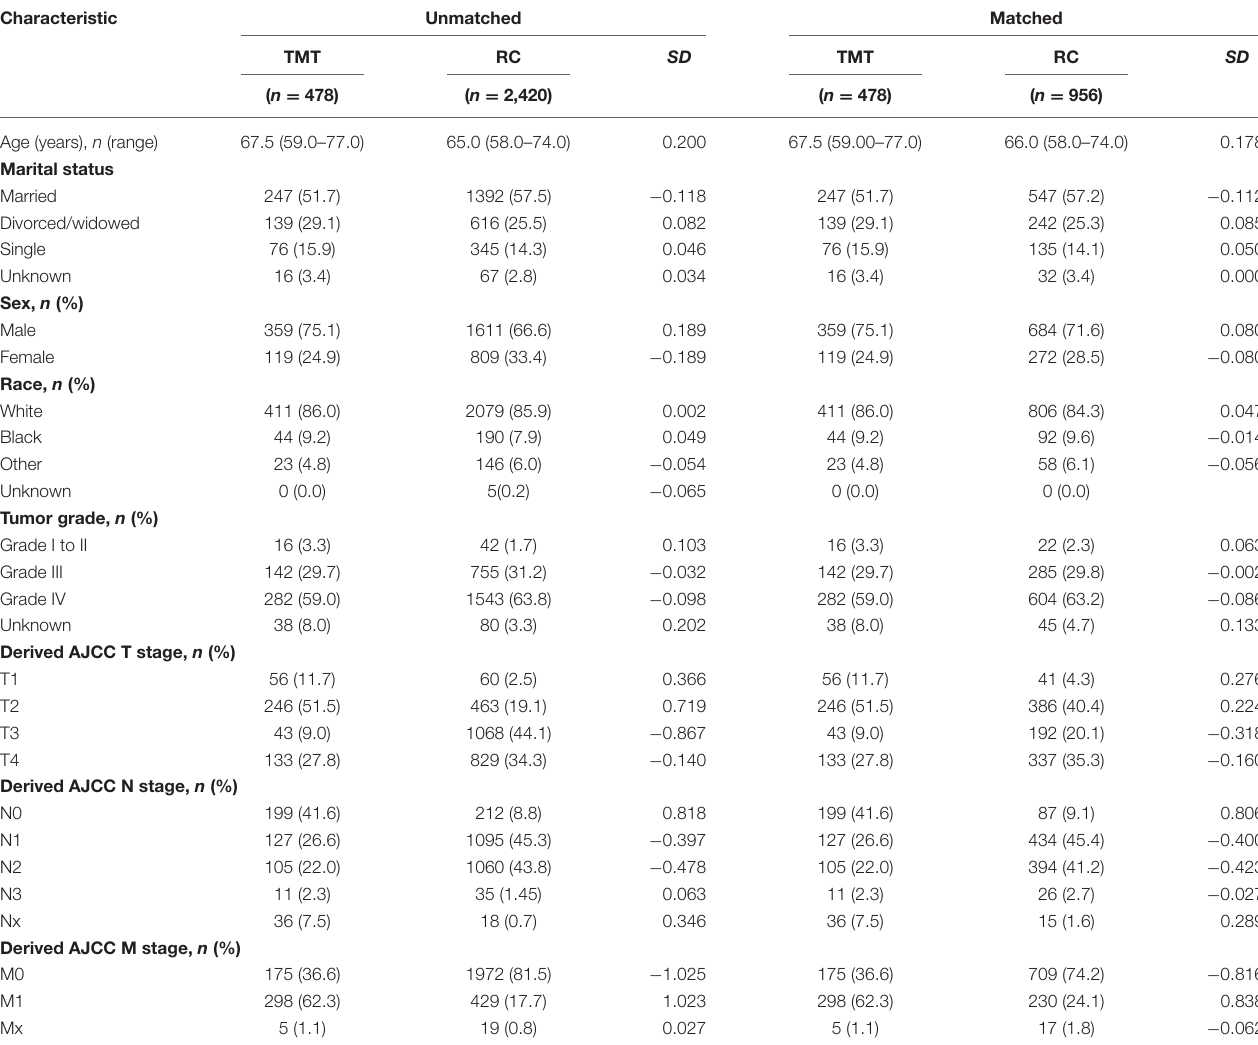
TABLE 1 | Patient demographics and clinical characteristics stratified by treatment type, with and without propensity score matching (ratio